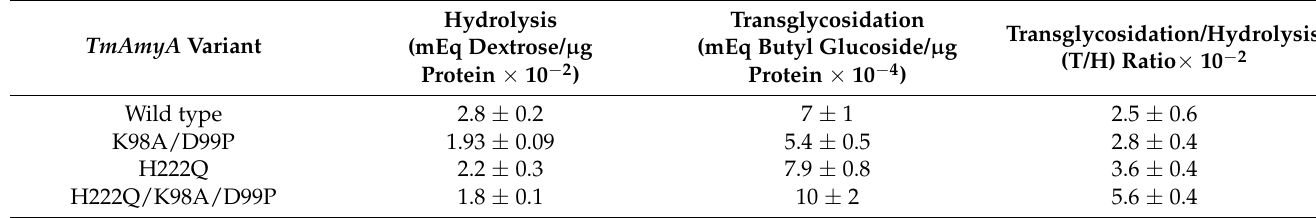
Figure 5. Transglycosylation/Hydrolysis (T/H) ratio of glycosidases. ( a ) TmAmyA and its variants; ( b ) TmGTase and its variants. Transglycosidation and hydrolysis values were normalized to each wild-type enzyme, which has the coordinates (1,1). The dashed lines indicate equivalent T/H ratios. The central diagonal corresponds to the wild-type enzyme. Enzymes with a better T/H ratio are over the central diagonal line, and enzymes with a better H/T ratio are under the central diagonal line. Table 1. TmAmyA variants production after 12 h of reaction.